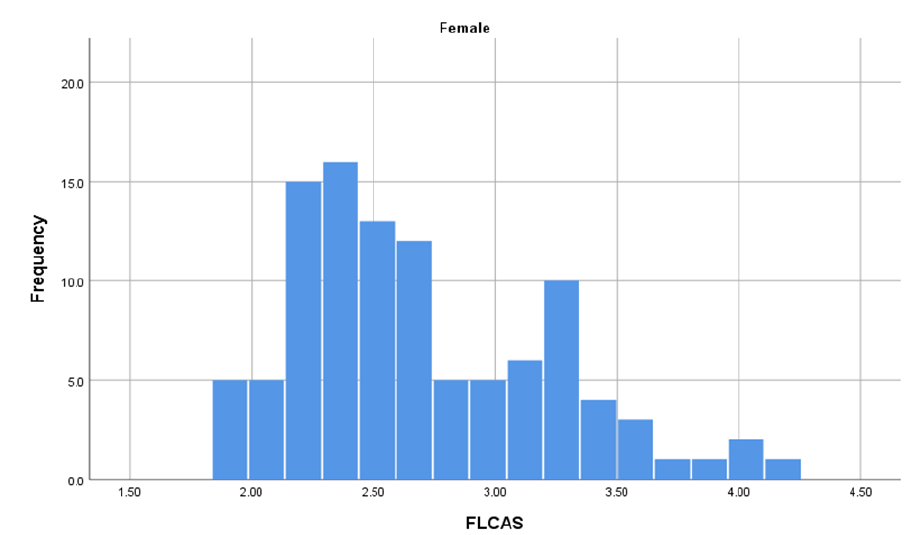
Figure 3. Distribution of scores for the FLCAS scale for female participants